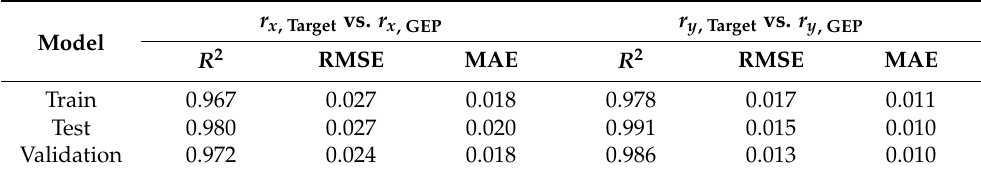
Table 2. Performance results of the GEP